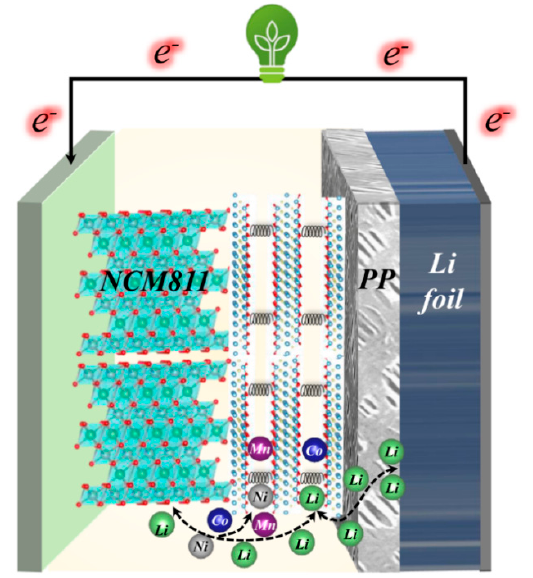
Figure 8. Schematic diagram of the mechanism of MXene / PP to enhance the NCM811 performances.